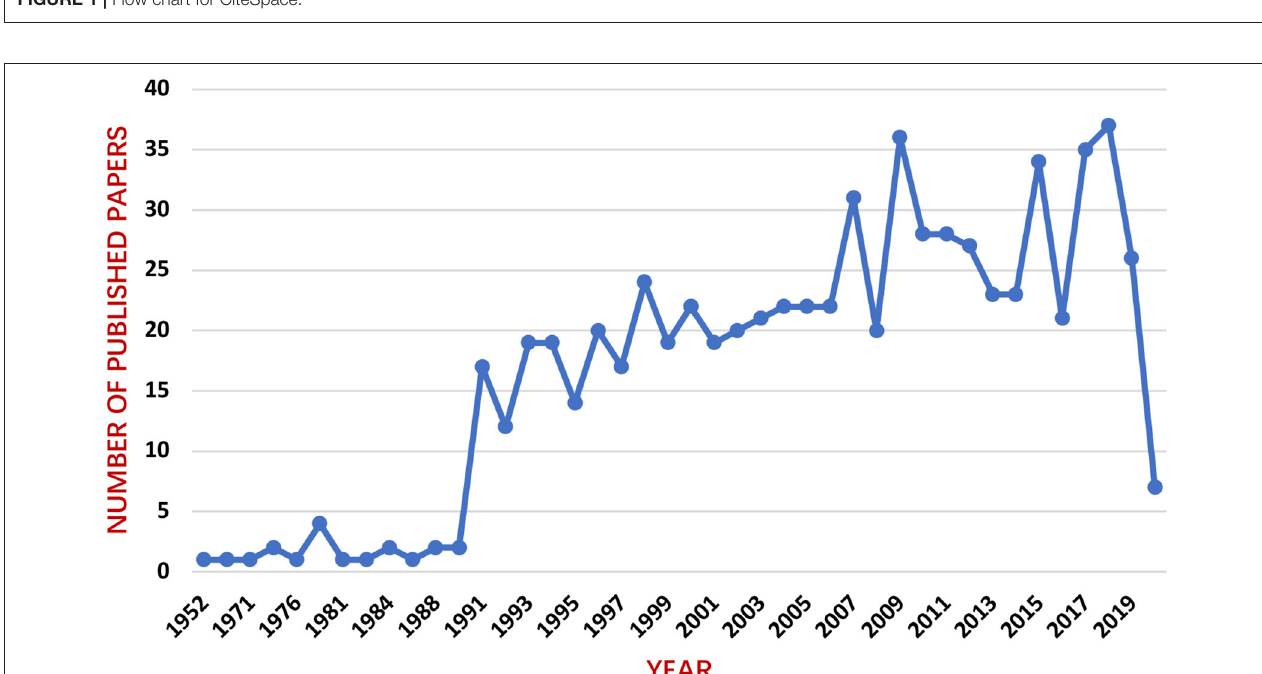
FIGURE 1 | Flow chart for CiteSpace.